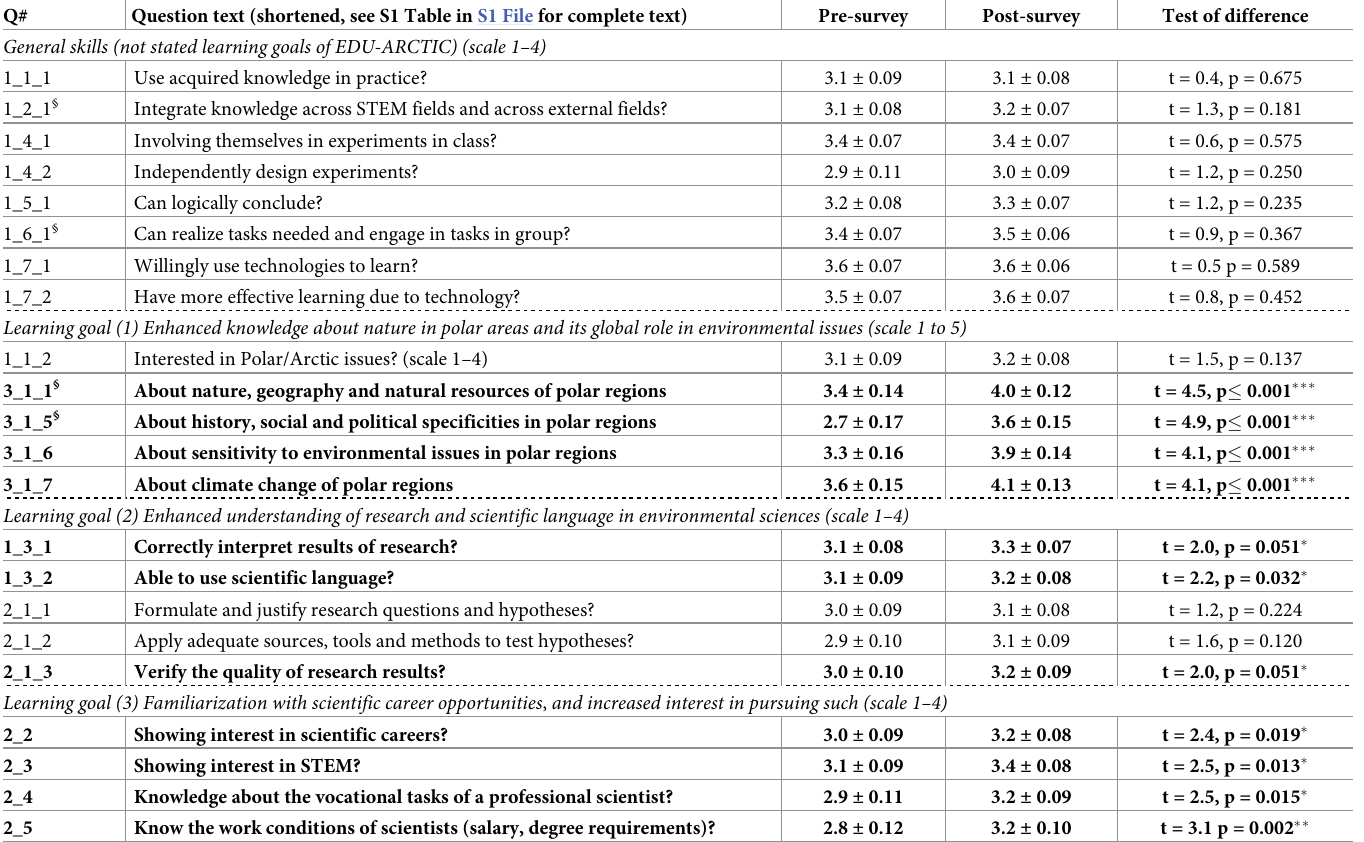
Table 1. Results of teacher-evaluations (online surveys) of learning outcomes for pupils 13–20 years of age participating in the open online course EDU-ARCTIC (2016–2019). Results pertain to the teacher’s collective assessment of the pupils in their class. N = 255 (46% of all active) teachers with 25,398 pupils in the pre-survey, and 73 (13%) teachers with 3,428 pupils in the post-survey. Scores (means ± 1 SE) denote levels of skill/learning goal among the pupils, on scales 1–4 or 1–5, where 1 = lowest and 4 or 5 = highest. Questions marked with § comprise merged questions that asked for similar information, after testing each merged question separately and finding that they yielded similar results. Bolded questions = significant difference between pre- and